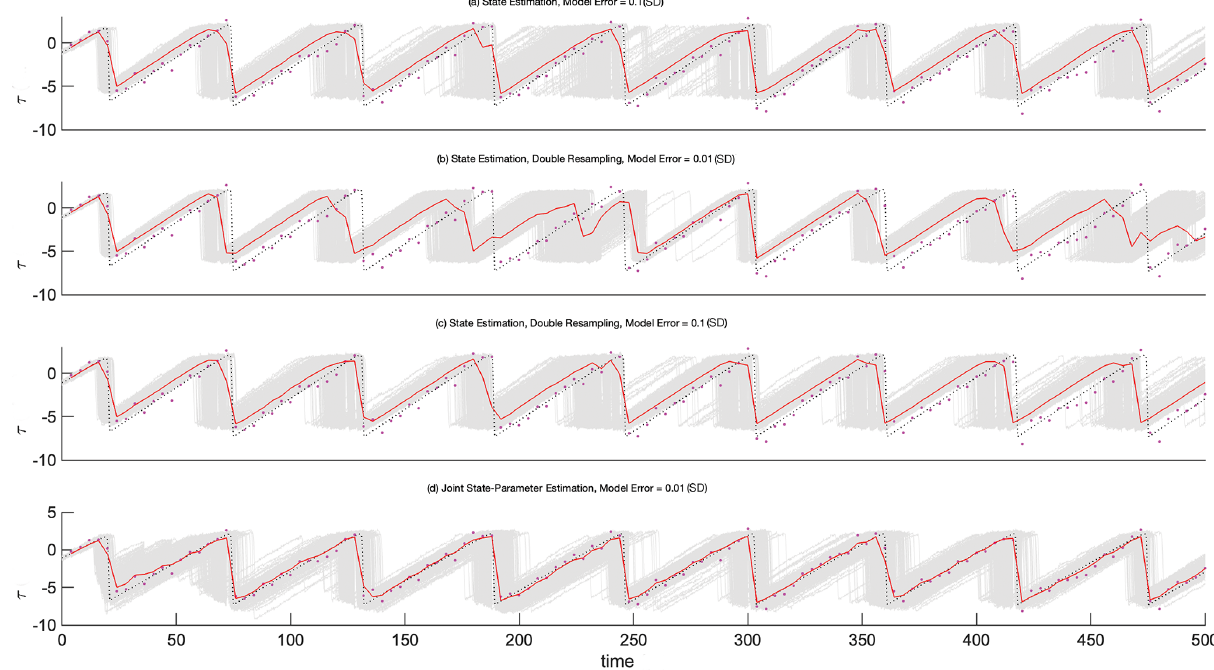
Figure 8. The evolution of particles with time for intermediate bias in state estimation with (a) higher model error ( η t = 0.1), (b) double resampling ( η t = 0.01), (c) a combination of higher model error ( η t = 0.1) and double resampling, and (d) joint state-parameter estimation ( η t = 0.01).